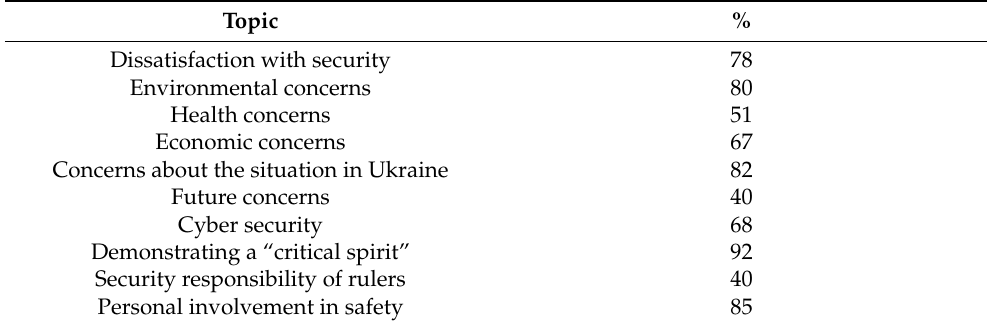
Table 2. Percentage of support for topics discussed in the discussion groups. Authors’ own elaboration. Topic % Dissatisfaction with security 78 Environmental concerns 80 Health concerns 51 67